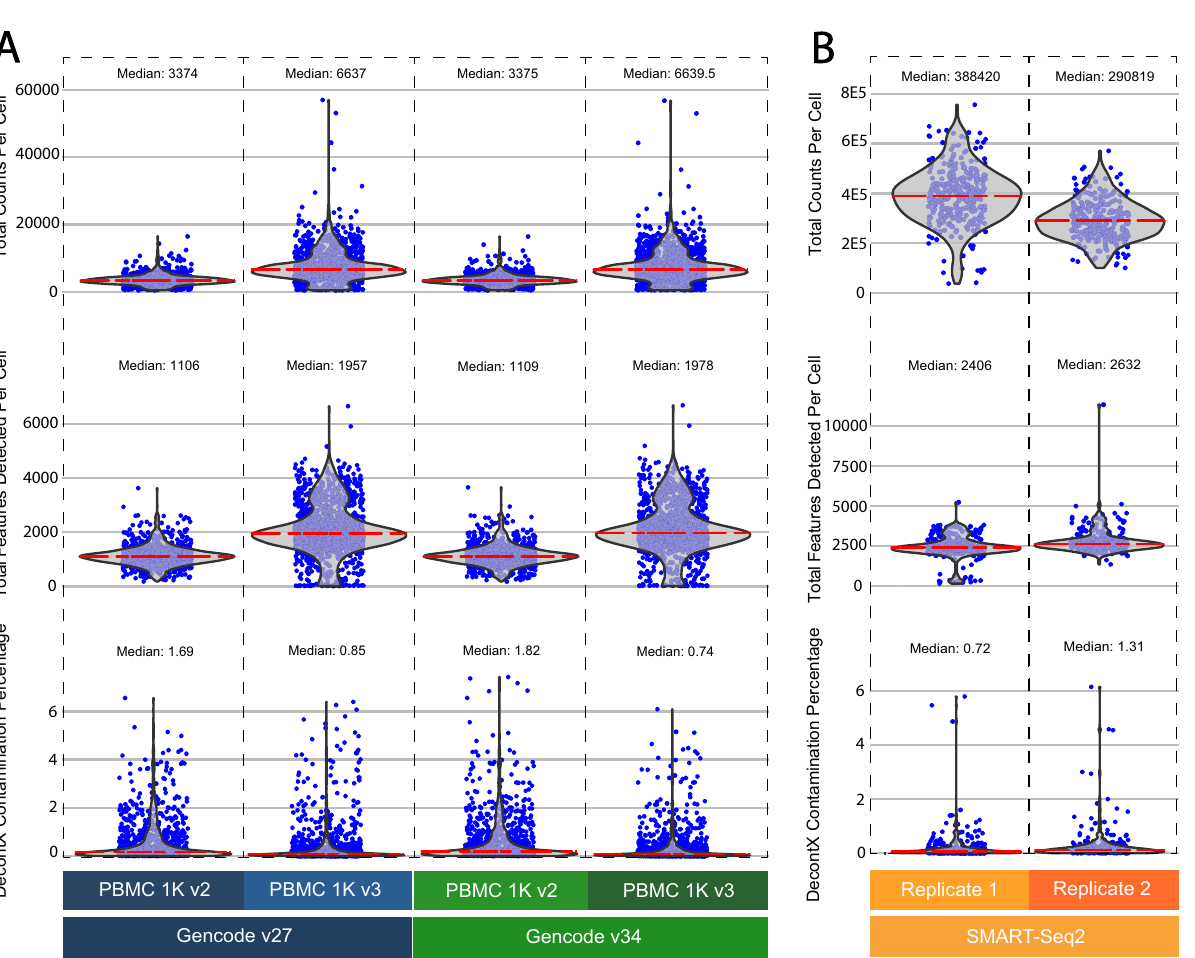
Fig. 4 Application of SCTK-QC to PBMC datasets. A QC metrics were generated by the SCTK-QC pipeline for 1K healthy donor Peripheral Blood Mononuclear Cell (PBMC) datasets from 10X Genomics. Violin plots generated by the pipeline demonstrate higher capture sensitivity of the 10x v3 Chromium chemistry. Furthermore, lower ambient RNA contamination was observed in the samples run with v3 chemistry compared to samples pro fi led with the v2 chemistry. B The SCTK-QC pipeline was applied similarly on a PBMC dataset generated by SMART-Seq2. A higher number of features were detected per cell in the SMART-Seq2 datasets compared to either of the 10X Genomics